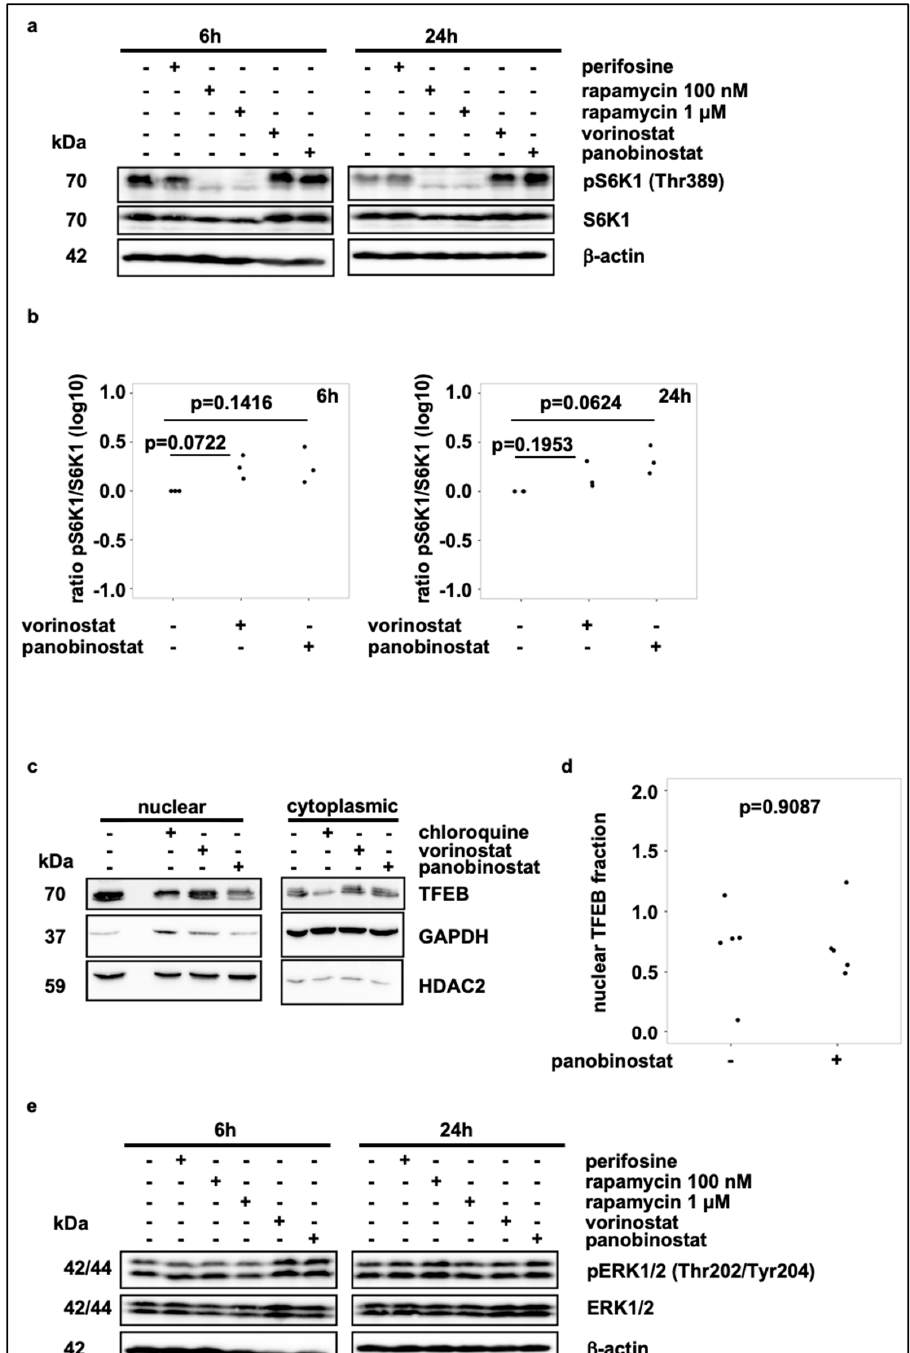
Figure 3. Broad-spectrum HDAC inhibitor treatment does not reduce mTORC1 activity. ( a ) Western blot analysis of pS6K1 and S6K1 levels after 6 h and 24 h treatment with vorinostat (500 nM) or panobinostat (10 nM). Rapamycin (100 nM and 1 µM) was used as negative control for mTORC1 activity and thus S6K1 phosphorylation. Note that blots were also used to analyze ERK1/2 phosphorylation in Figure 3e. ( b ) Quantification of Western blot analysis of pS6K1 and S6K1 expression, normalized to solvent control. Statistical analyses: ANOVA with Tukey’s multiple comparison test. ( c ) Subcellular localization analysis of TFEB on SK-N-BE(2)-C cells treated for 24 h with vorinostat (500 nM) or panobinostat (10 nM). Chloroquine (50 µM) was used as positive control for TFEB translocation. GAPDH was used as cytoplasmic marker, HDAC2 was used as nuclear marker. ( d ) Quantification of nuclear TFEB by Western blot analysis from subcellular localization analysis. Statistical analyses: t -test. ( e ) Western blot analysis of pERK1/2 and ERK1/2 expression after 6 h and 24 h treatment with vorinostat (500 nM) or panobinostat (10 nM). Note that identical blots were used to analyze S6K1 phosphorylation in Figure